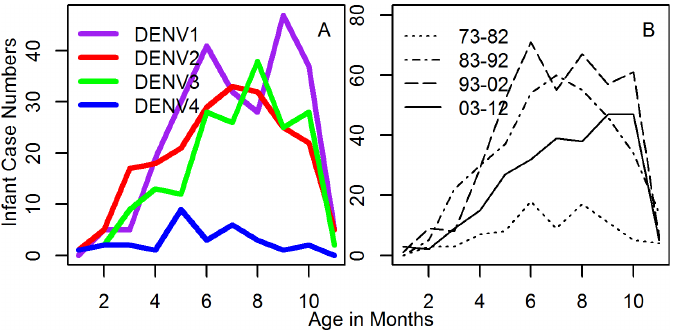
Fig 3. Figures show: A) number of cases in each month age group by serotype over all years, B) number of cases in each month age group by decade over all